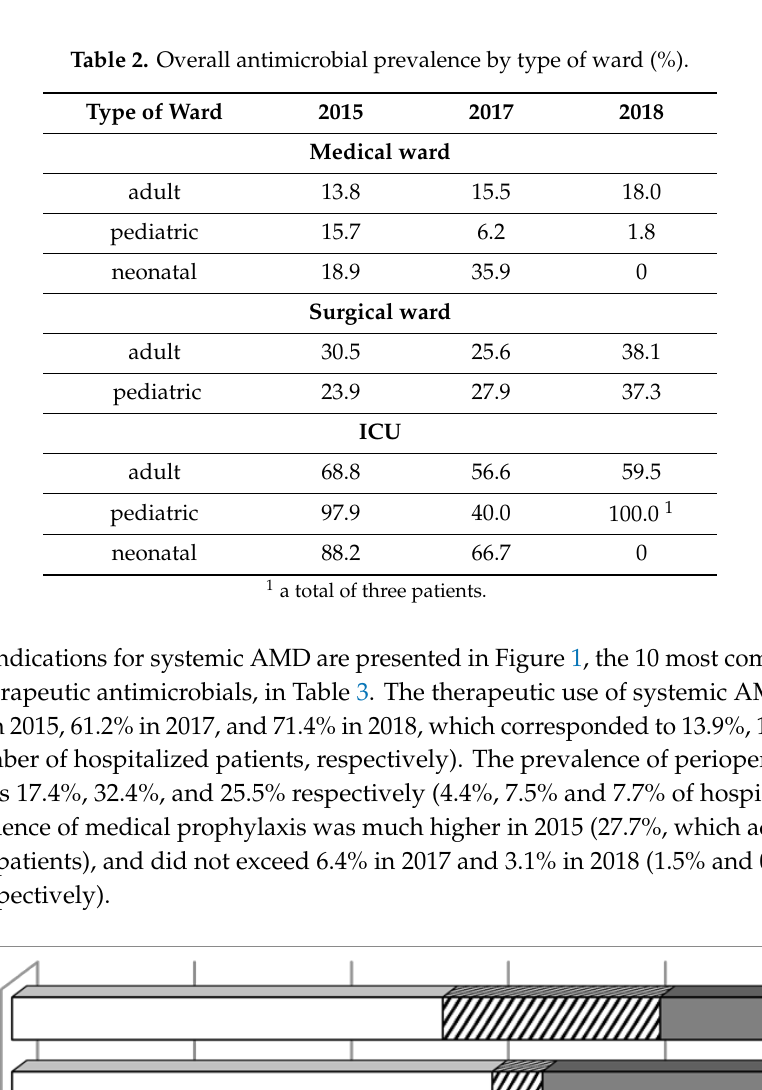
Table 3. The 10 most common diagnoses treated with therapeutic antimicrobials (%).